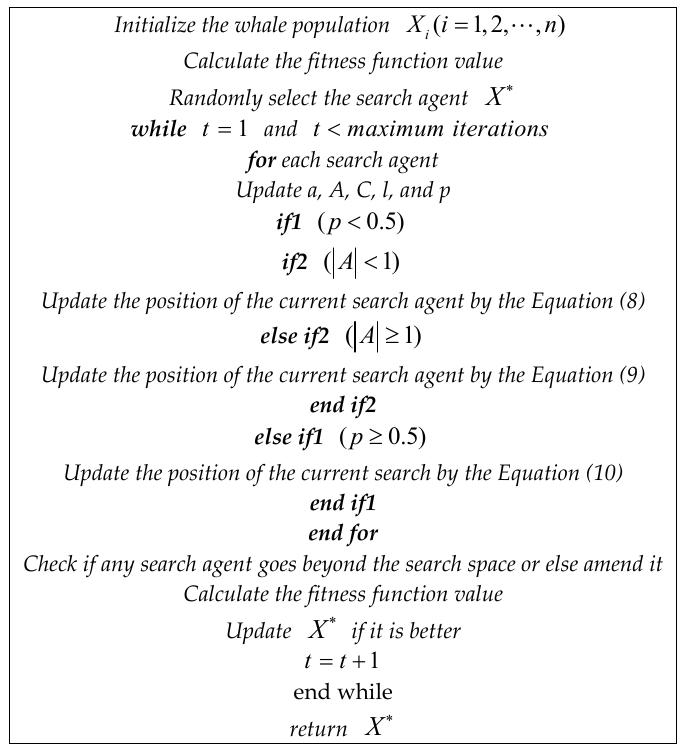
Figure 1. Pseudo code of the whale ‐ optimization algorithm (WOA) algorithm.